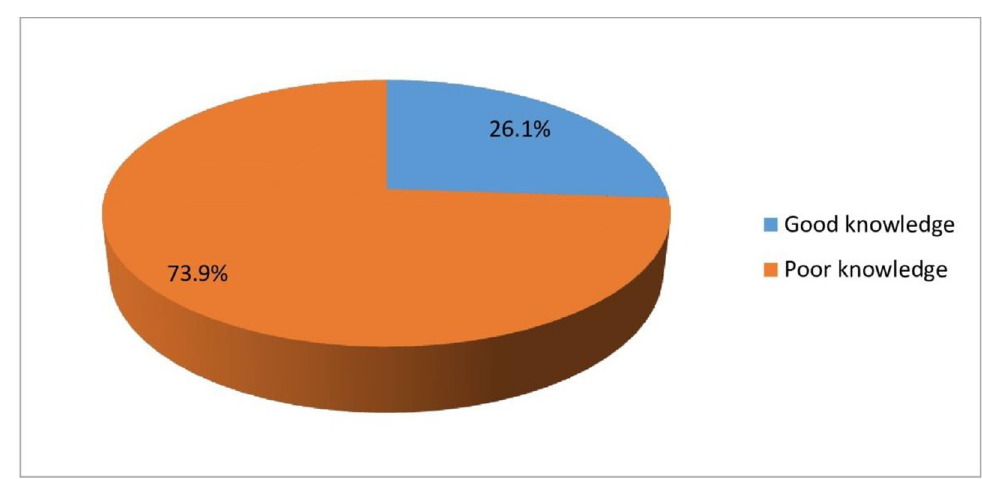
Fig 2. Overall knowledge of the new technologies used in the reduction of maternal mortality among respondents. Most (170;73.9%) of the nurses and midwives had poor knowledge of new technologies of maternal mortality reduction while 60(26.1%) of them had good knowledge (Fig